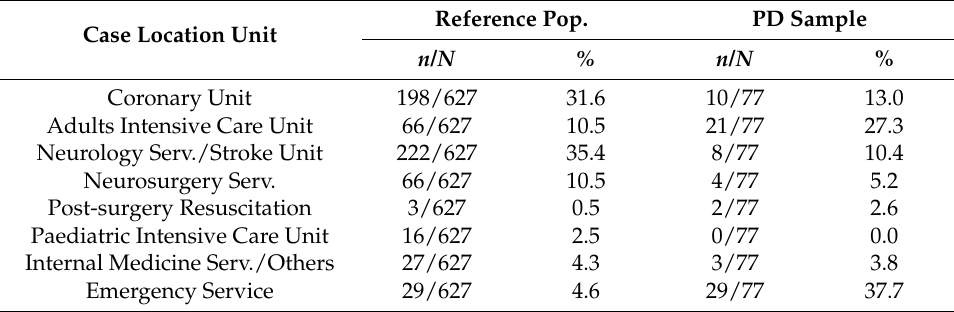
Table 5. Patient distribution according to case detection